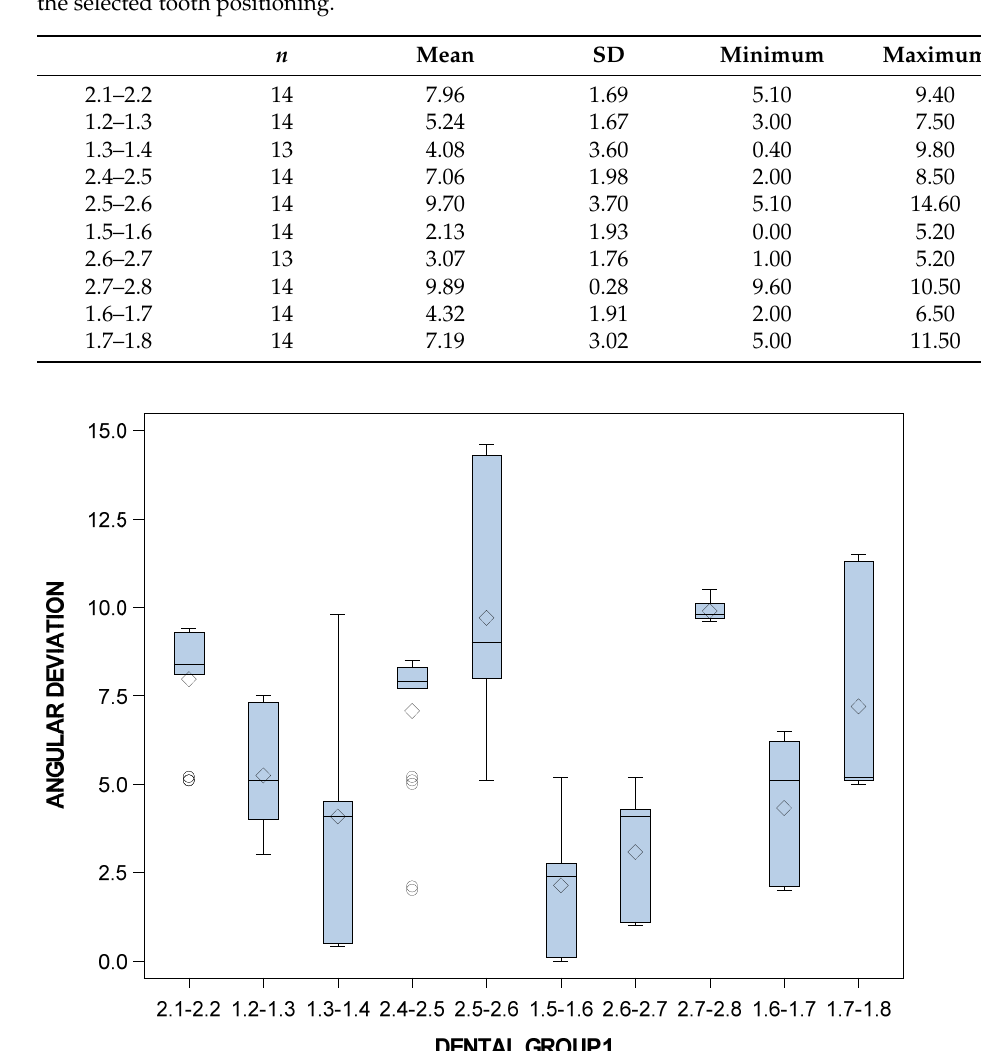
Figure 13. Box plot of the angular deviations of the orthodontic micro-screws in the selected tooth positioning.